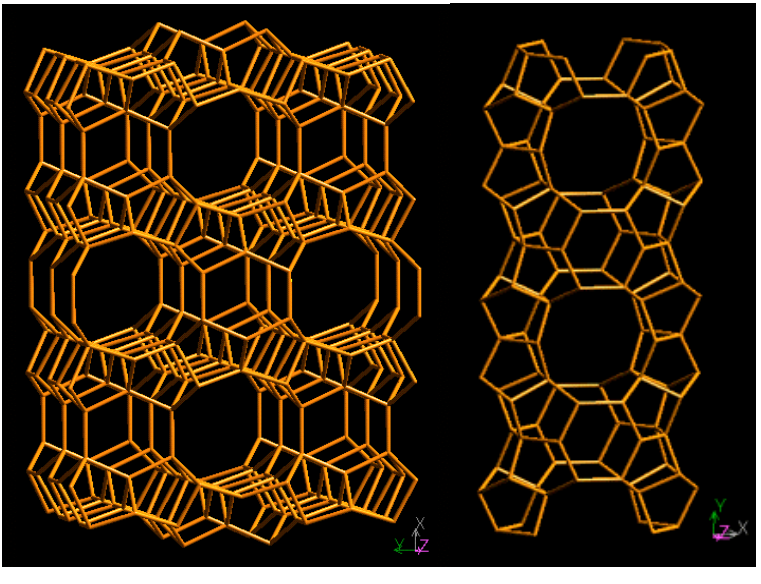
Figure 3. The FER type zeolite framework (viewed along [001] and